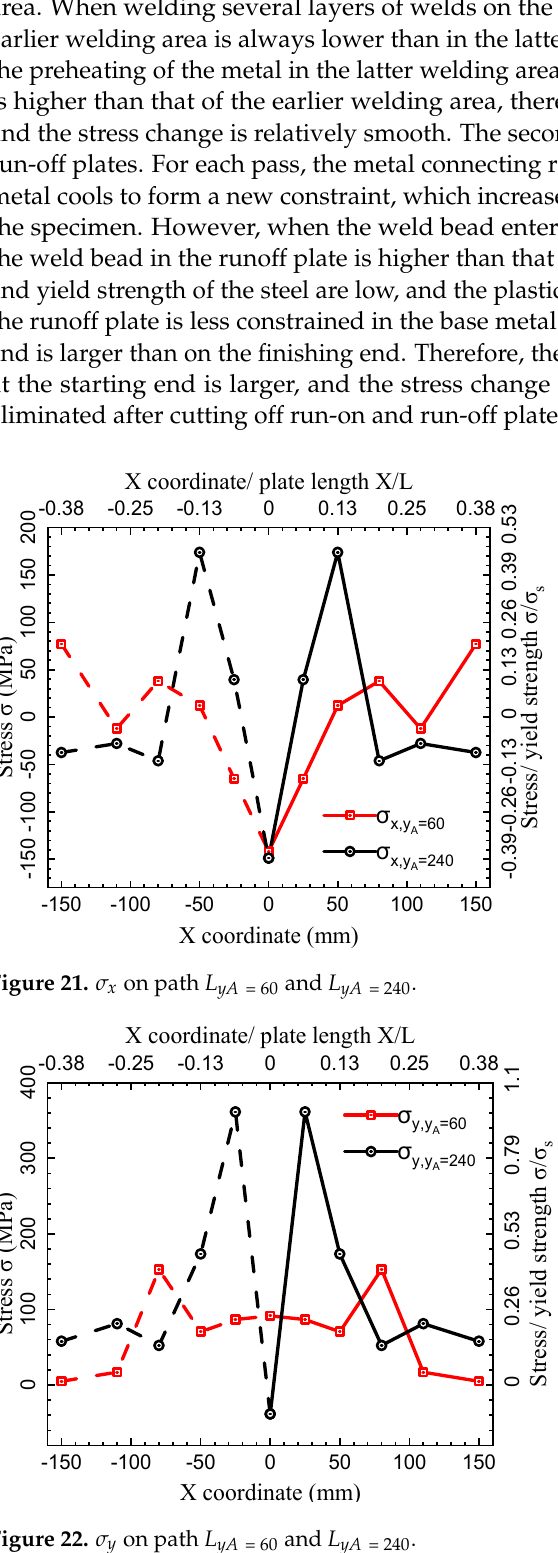
Figure 22. σ y on path L yA = 60 and L yA = 240